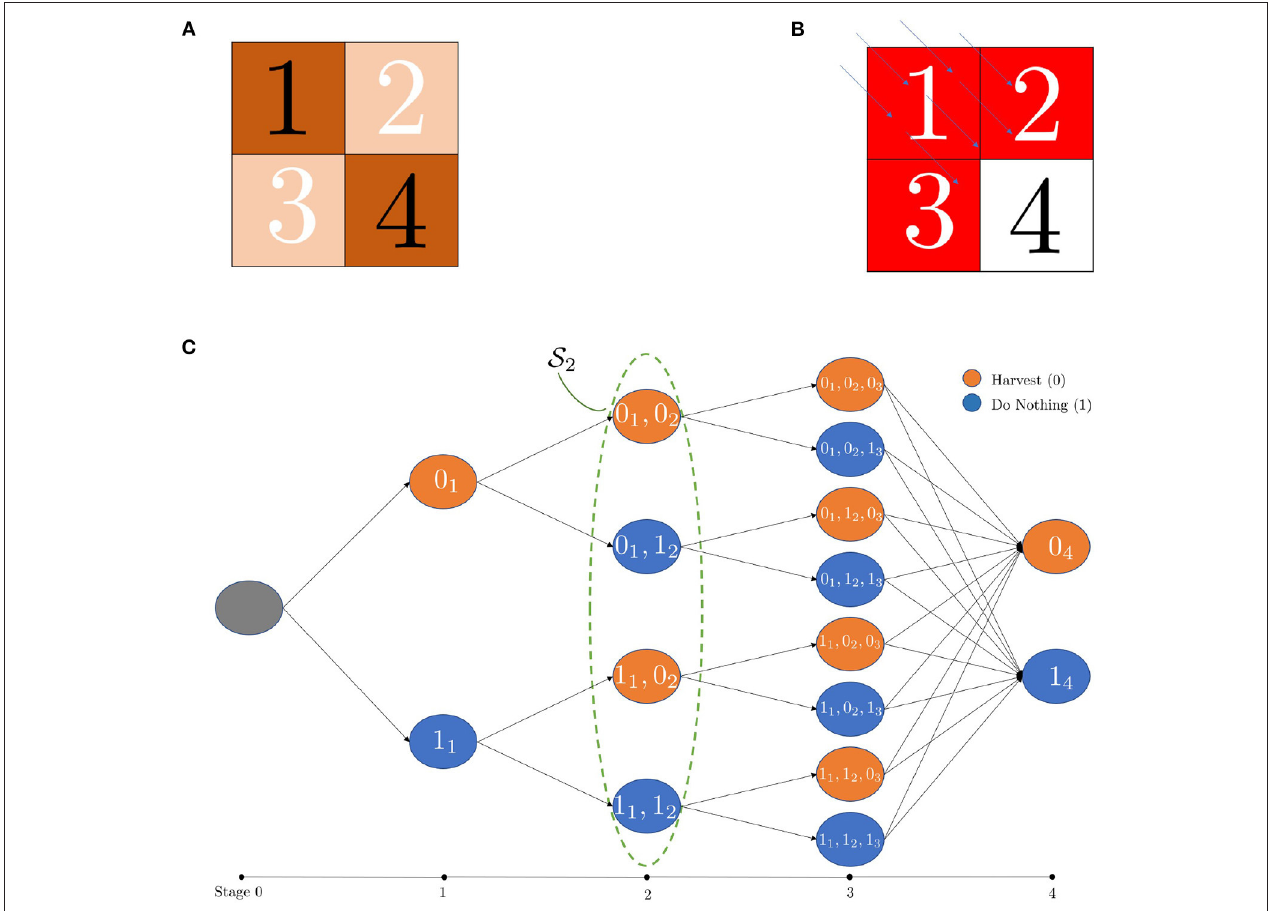
FIGURE 1 | (A) 2 2 matrix forest. (B) Northwest wind (blue) and the up-wind stands (red) for stand 4. (C) The state space of 2 ×